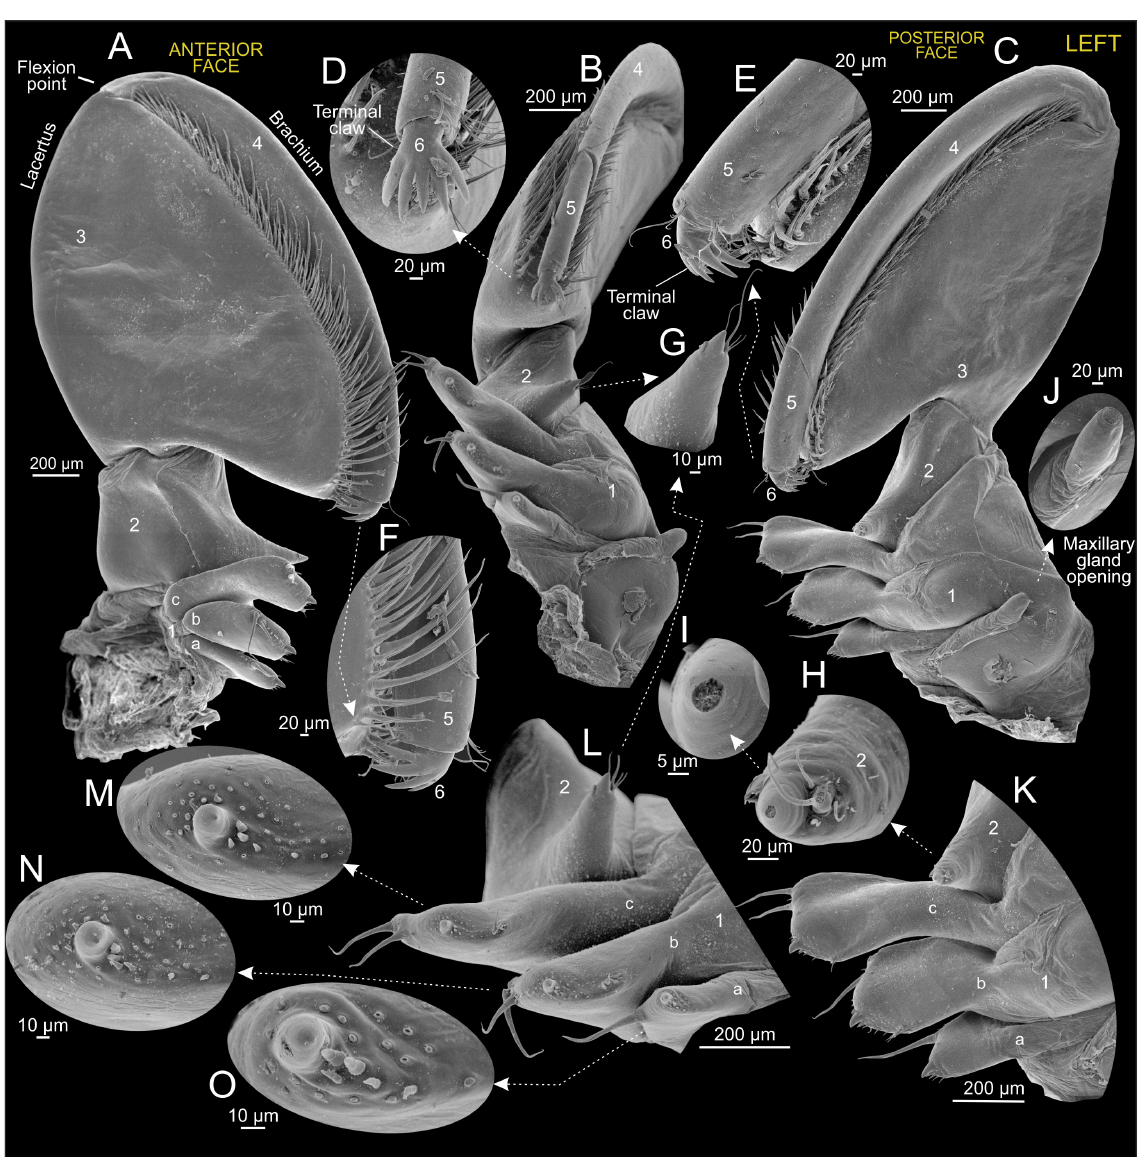
Fig. 7. Godzillius louriei sp. nov., holotype (NHMD 669698), left maxilla 2 (mx2), scanning electron microscopy. A . Anterior face of mx2; endites of segment 1 indicated as lowercase letters a–c. B . Apical view of mx2. C . Posterior face of mx2. D . Terminal claw, apical view. E . Terminal claw, posterior face. F . Terminal claw, anterior face. G . Endite of segment 2, median view. H . Endite of segment 2, posterior face. I . Hollowed conical tip of the endite of segment 2. J . Maxillary gland opening of mx2. K . Triplet endites of segment 1 (a–c) and singular endite of segment 2, posterior face. L . Triplet endites of segment 1 (a–c) and singular endite of segment 2, apical view. M . Conical spine on the third endite of segment 1, apical view. N . Conical spine on the second endite of segment 1, apical view. O . Conical spine on the first endite of segment 1, apical view. Small numbers represent segments of